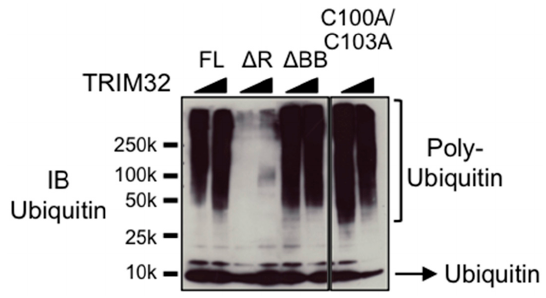
Figure 2. TRIM32 carrying mutations or deletion of the B-box shows activity similar to the wild-type protein. Increasing doses of recombinant full-length TRIM32 (FL), Δ RING ( Δ R), Δ B-box ( Δ BB) or C100A/C103A mutants were used as E3 ligase in an in vitro reaction with the UbE2D1 conjugating enzyme. Proteins were resolved by SDS-PAGE and poly-ubiquitin chains detected with anti-ubiquitin antibody.